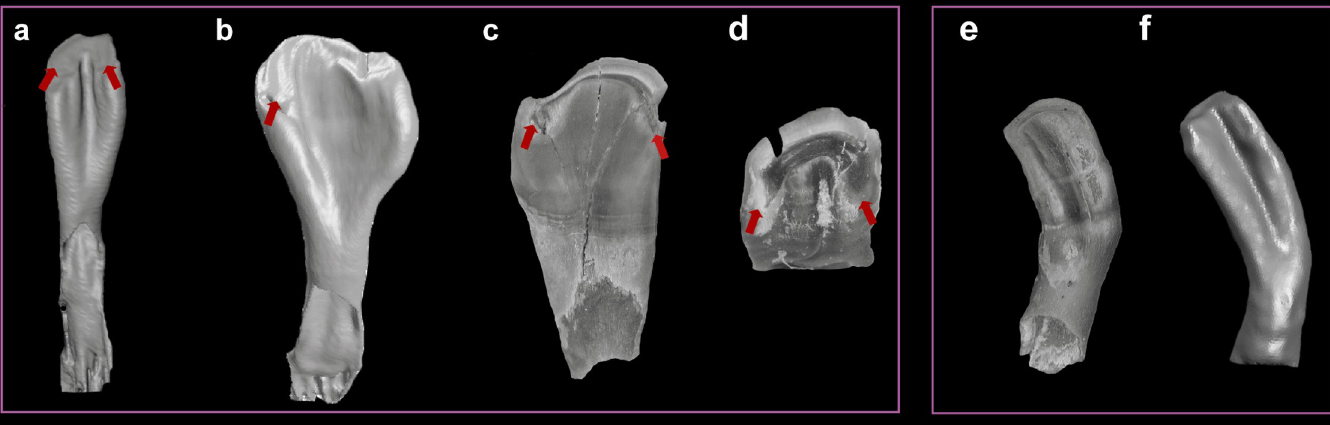
Fig 7. Additional morphological characters (besides the shape characters ( αβ ) in fossil and extant pharyngeal teeth (not to scale). ( a ), Capoeta sp., b3 tooth (extant) (SAPM-PI-00719, SNSB). ( b ), C . trutta , a5 tooth (extant) (SAPM-PI-02908, SNSB). ( c-d ), isolated fossil pharyngeal teeth (identified as shape class "C" and "F" respectively) (BGR 6, 16). ( e ), isolated fossil pharyngeal tooth (BGR 5). ( f ), C . capoeta , b2 tooth (extant) (GPIT-OS-00860 a ), both are identified as shape class "M". The ruptures of grinding surface are marked by red arrows (a, b, c, d) and an example of very similar tooth morphology in fossil (e) and extant (f) isolated pharyngeal teeth.